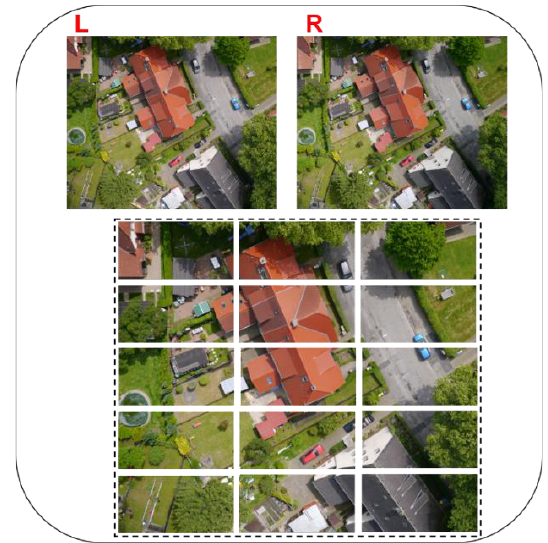
Figure 1. a) Training images-Stereopairs along with extracted patches from left